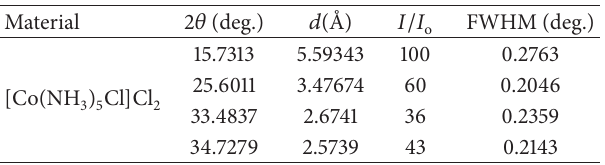
Table 1: Diffraction angle 2𝜃 (deg.), interplanar 𝑑 (˚A), relative intensity ( 𝐼/𝐼 o ), and full width at half maximum FWHM (deg.).